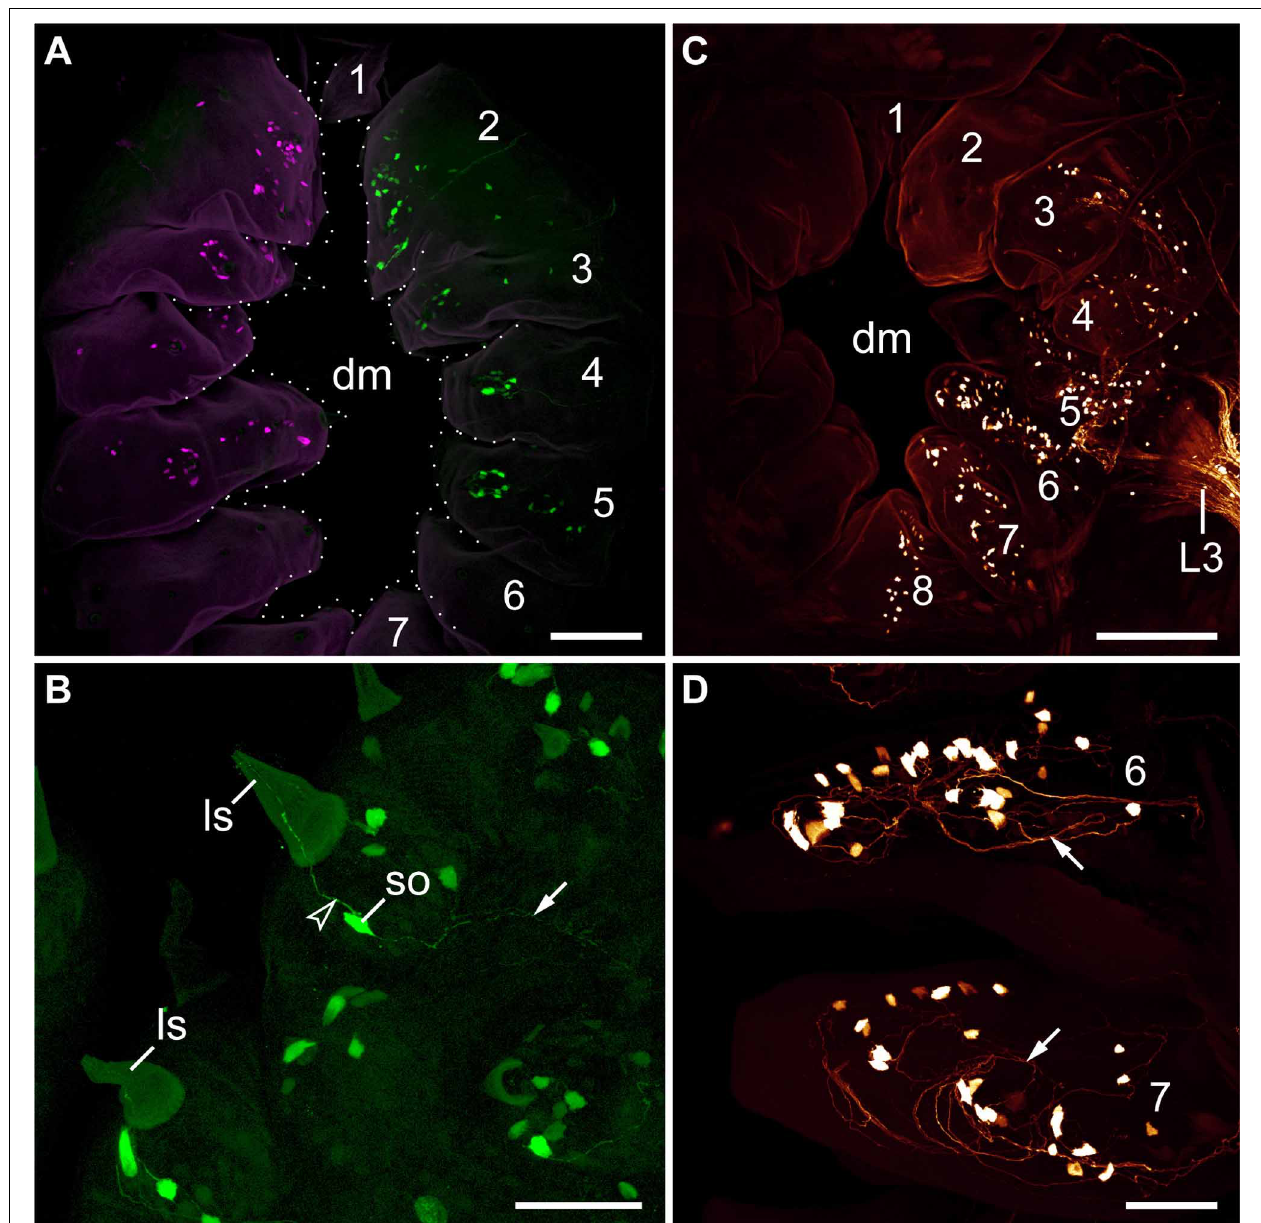
FIGURE 8 | Localization of somata of peripheral neurons associated with lip papillae in Euperipatoides rowelli . Anterograde fills with dextran coupled to the fluorescent markers tetramethylrhodamine or fluorescein. Maximum projection confocal micrographs. Lip papillae surrounding the mouth opening are numbered. (A) Overview (external perspective) showing the position of neuronal cell bodies within the lip papillae associated with the second pair of lip papillae nerves (L2). The nerves of each body side were labeled using two different fluorochromes (shown in magenta and green). Note that each nerve supplies the second to fifth pairs of lip papillae. The unpaired eighth papilla is not seen, as it lies beneath the seventh pair of lip papillae. (B) Details of lip papillae from the same preparation as in (A) (anterograde fill of L2; external perspective). Note the bipolar neurons associated with each